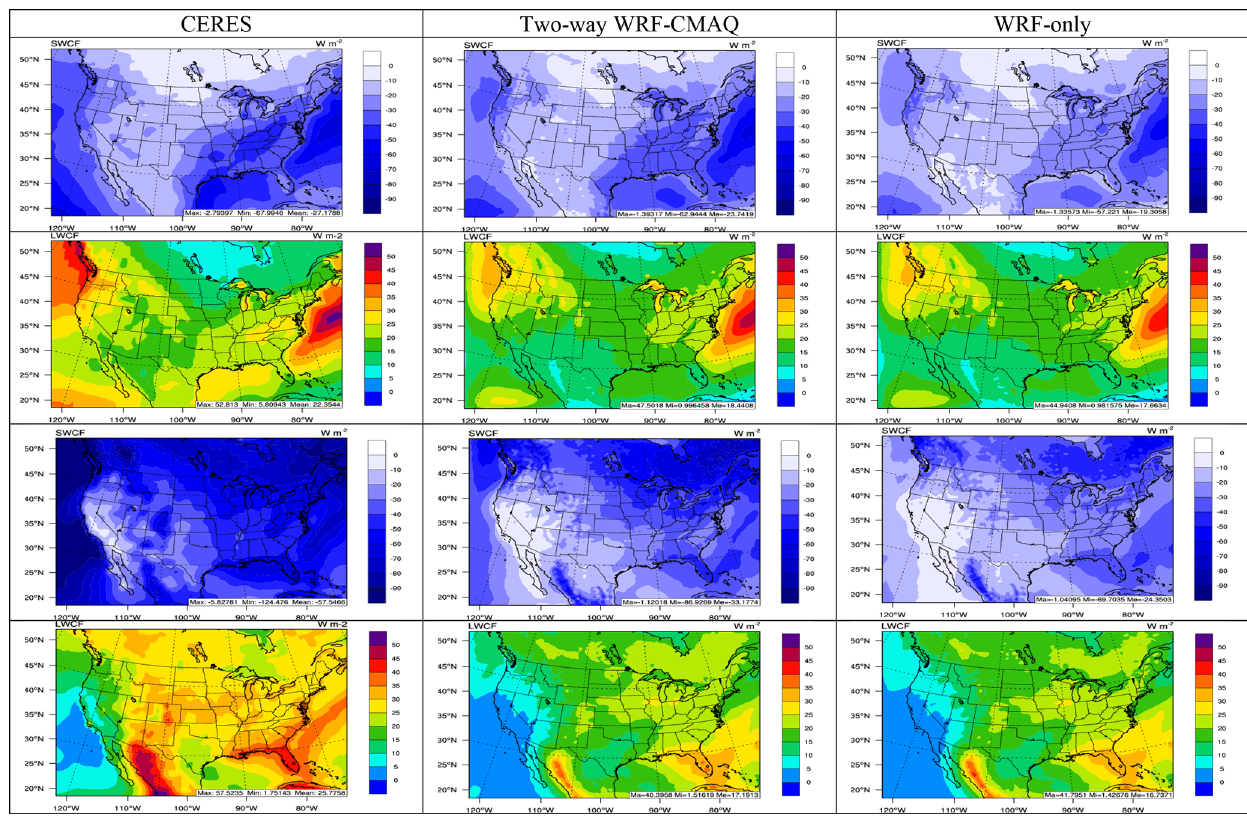
Figure 8. Spatial distribution of 5-year average SWCF in winter, LWCF in winter, SWCF in summer, and LWCF in summer (from top to bottom) between CERES observations (left column) vs. two-way WRF-CMAQ (center column) and WRF-only (right column) in